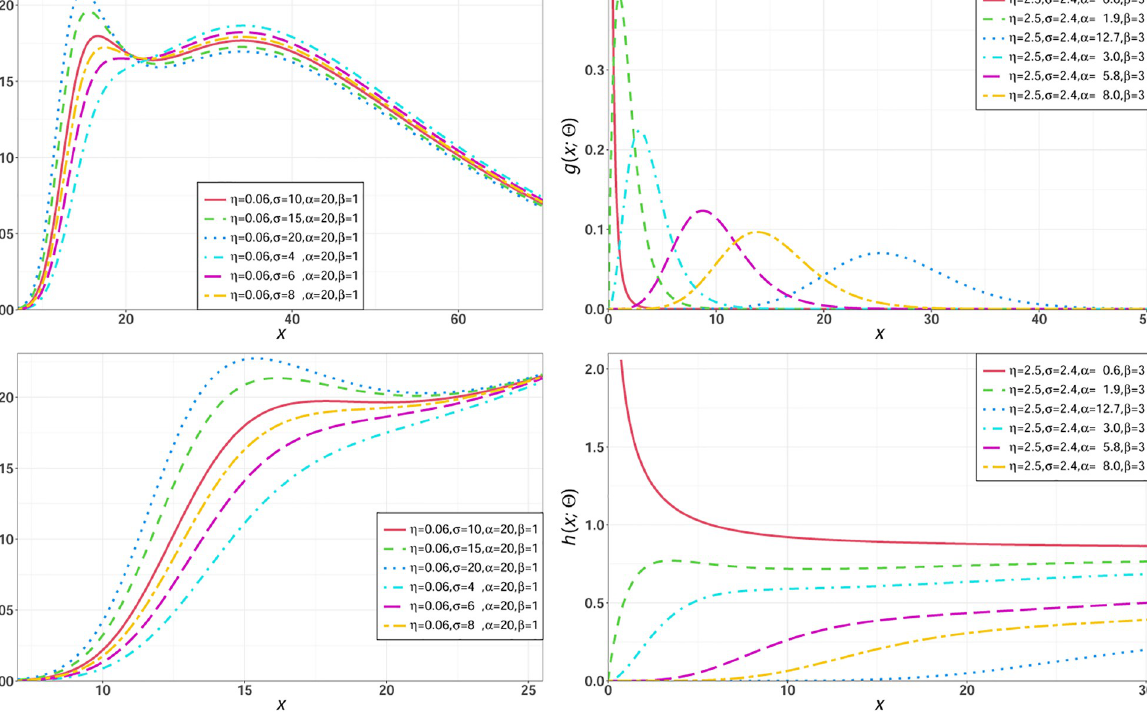
Fig 3. Different shapes for the pdf and hrf of the NEHTG